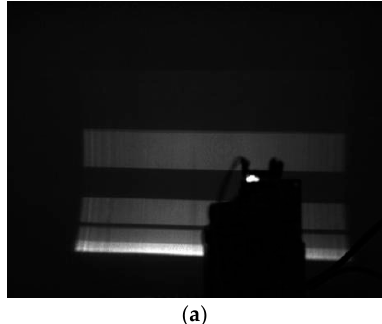
Figure 20. Projection binary fringes 10101010.